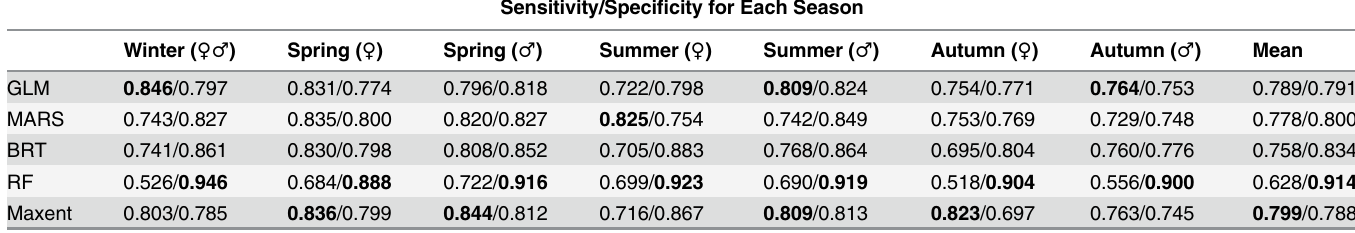
Bold numbers indicate the highest AUC score for the season and sex. GLM = Generalized Linear Models using logistic regression in a maximum likelihood framework; MARS = Multivariate Adaptive Regression Splines; BRT = Boosted Regression Trees; RF = Random Forest; Maxent = Maxent approach to maximum entropy